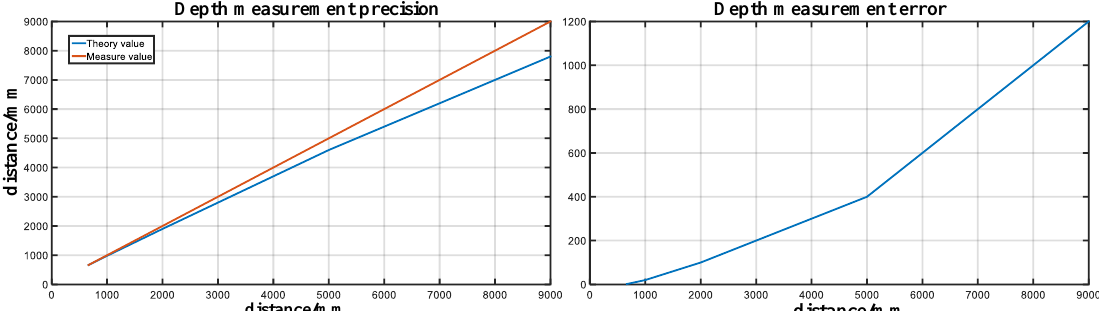
Figure 16. The precision curve and error curve of the depth measurement of the binocular camera MYNT EYE